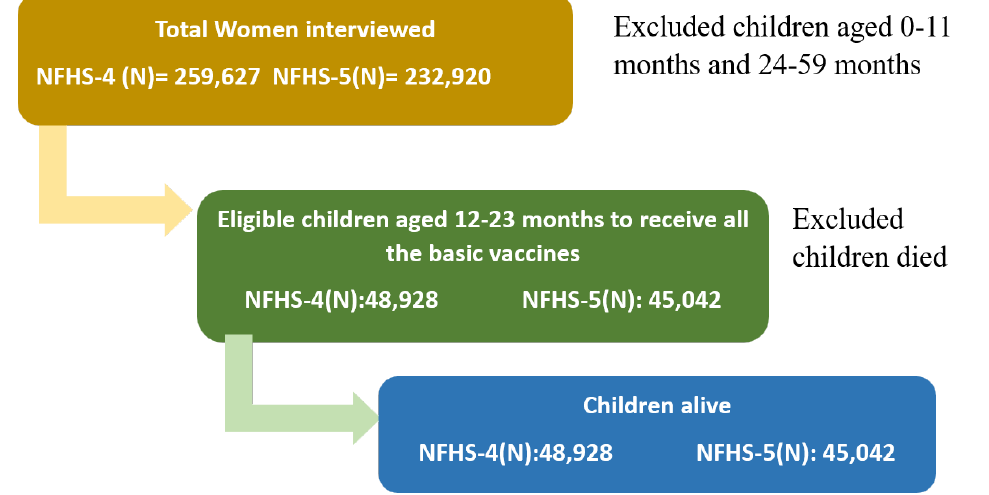
Figure 1. Selection procedure of the study sample from NFHS-4 and NFHS-5.